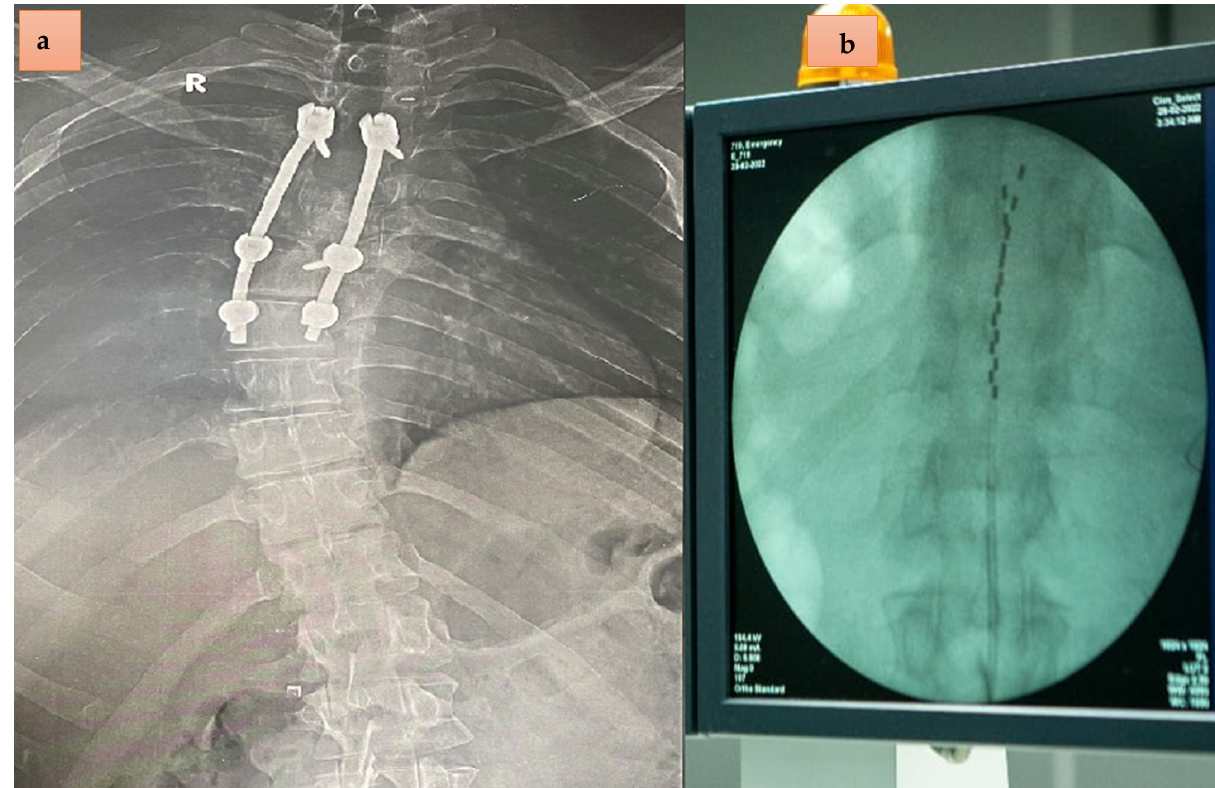
Figure 1. ( a ). The anterior posterior X-ray view of the spine with bilateral rods for spinal fusion and apparent right upper thoracic scoliosis of a T3 complete 25-year-old male with SCI. ( b ). Percutane- ous spinal cord epidural stimulation leads placed to cover the distance from T11–T12. The percuta- neous leads were placed intentionally above the upper border of T11 to offset for rostral migration, which is likely to happen with percutaneous implantation. Surgery lasted for one and a half hours with less than 10 mL of blood loss. The oper- ation was uneventful with smooth post operative recovery. An intra-operative trial was performed to ensure the lower extremity muscle contraction without EMG recording. In- tra-operative and immediate postoperative fluoroscopy showed optimal positioning of the leads spreading from the midline of the T11 to T12 vertebral levels (Figure 1b). The participant was then discharged from the hospital on the third day. Unfortunately, on 3 March, the anterior–posterior X-ray view showed migration of the left lead outside the epidural space, whereas the right lead migrated from the proximal rim of T11 to the upper 1/3 of the T12 vertebrae (Figure 2) [15]. The migration of the leads occurred during his travel home to Cairo, Egypt (~250 km).